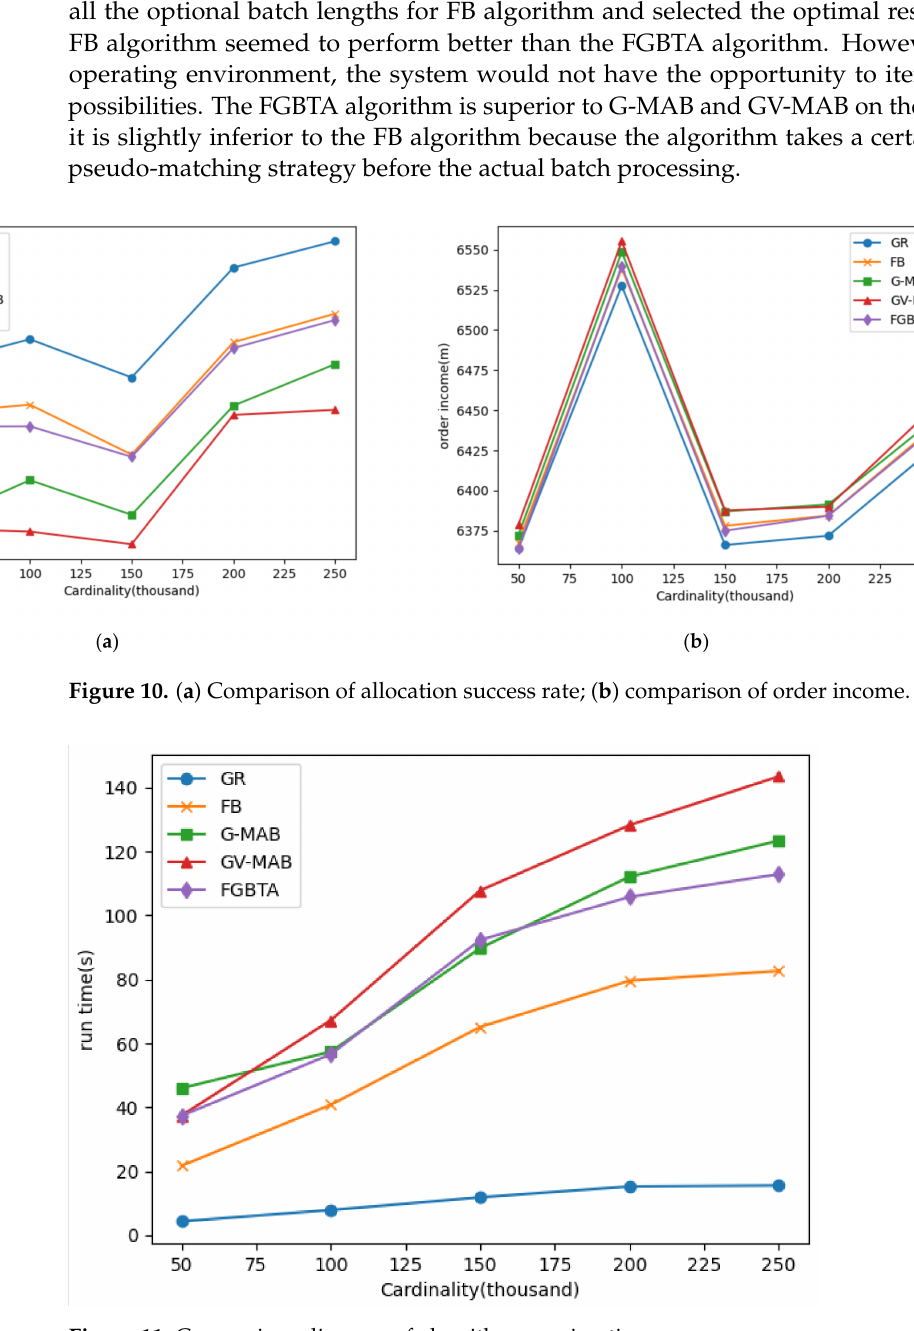
Figure 11. Comparison diagram of algorithm running